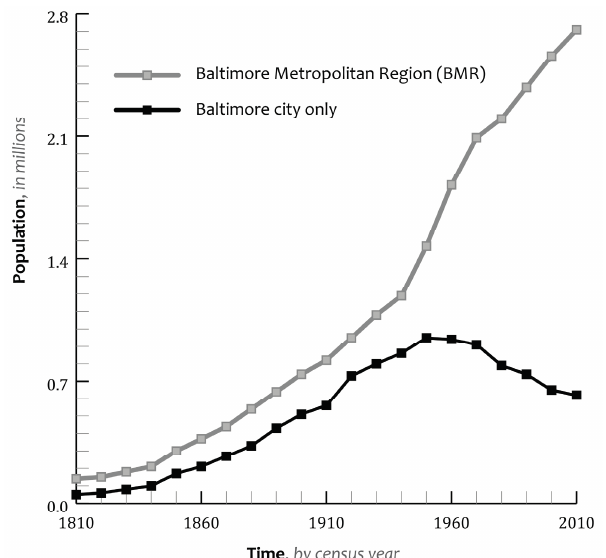
Figure 2. Census population counts for Baltimore city and the entire metropolitan region, including the city, between 1810 and